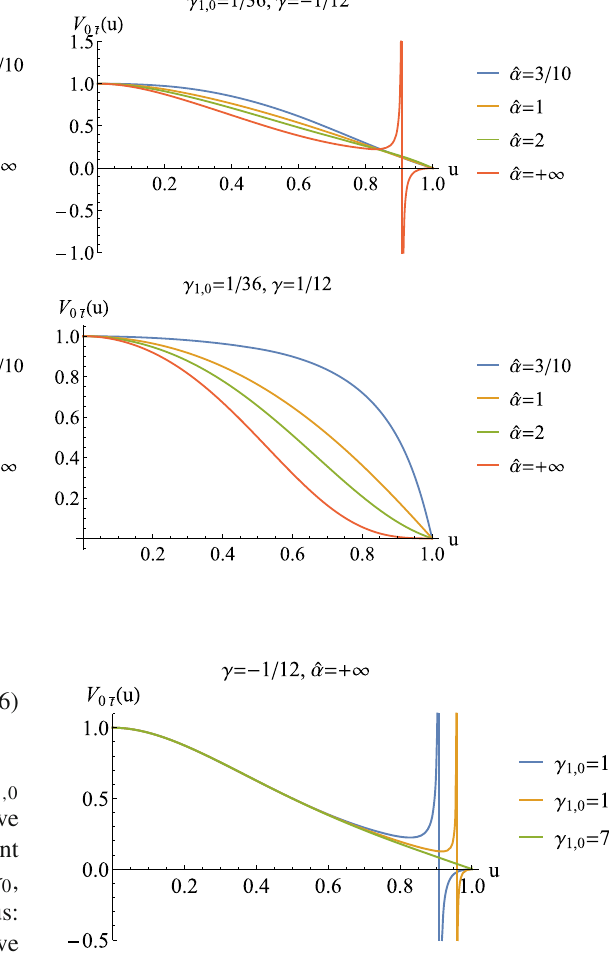
Fig. 20 The potentials V 0 ¯ t ( u ) with γ = − 1 / 12 and ˆ α = +∞ and different γ 1 ,